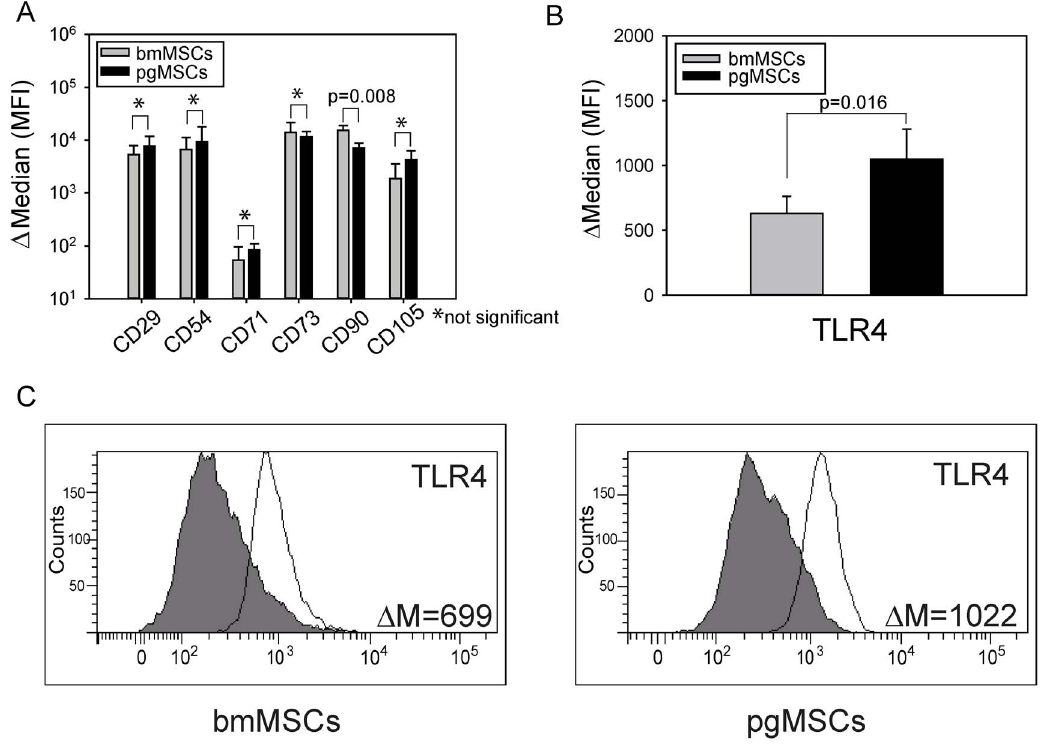
Figure 1. Immunophenotyping of bmMSCs and pgMSCs. (A/B) Flow cytometric analysis of MSCs; data are presented as D Median defined as the mean fluorescence intensity (MFI) of the specific antibody minus MFI of the isotype control antibody. Bar graphs show the median from 4–5 independent experiments (bmMSCs, n=4; pgMSCs, n=5). (B/C) TLR4 expression of bmMSCs and pgMSCs was determined by flow cytometry (five independent experiments). The Mann-Whitney U test was used for statistical analysis; significance was set at the level of P # 0.05. (C) Data are shown as an overlay histogram: isotype control (gray) and specific cell surface marker for TLR4 (white). Representative result from 1 out of 5 independent experiments (bmMSCs, n=5; pgMSCs, n=5).